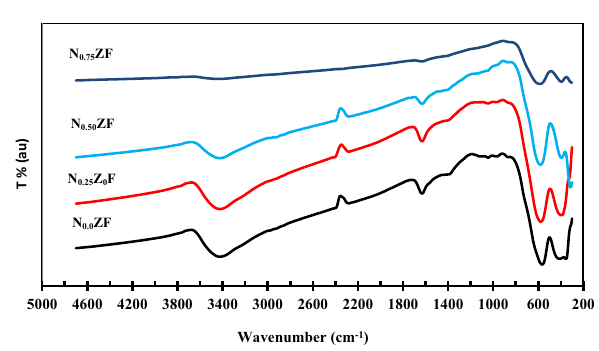
Figure 7. FTIR spectra for the prepared NZF